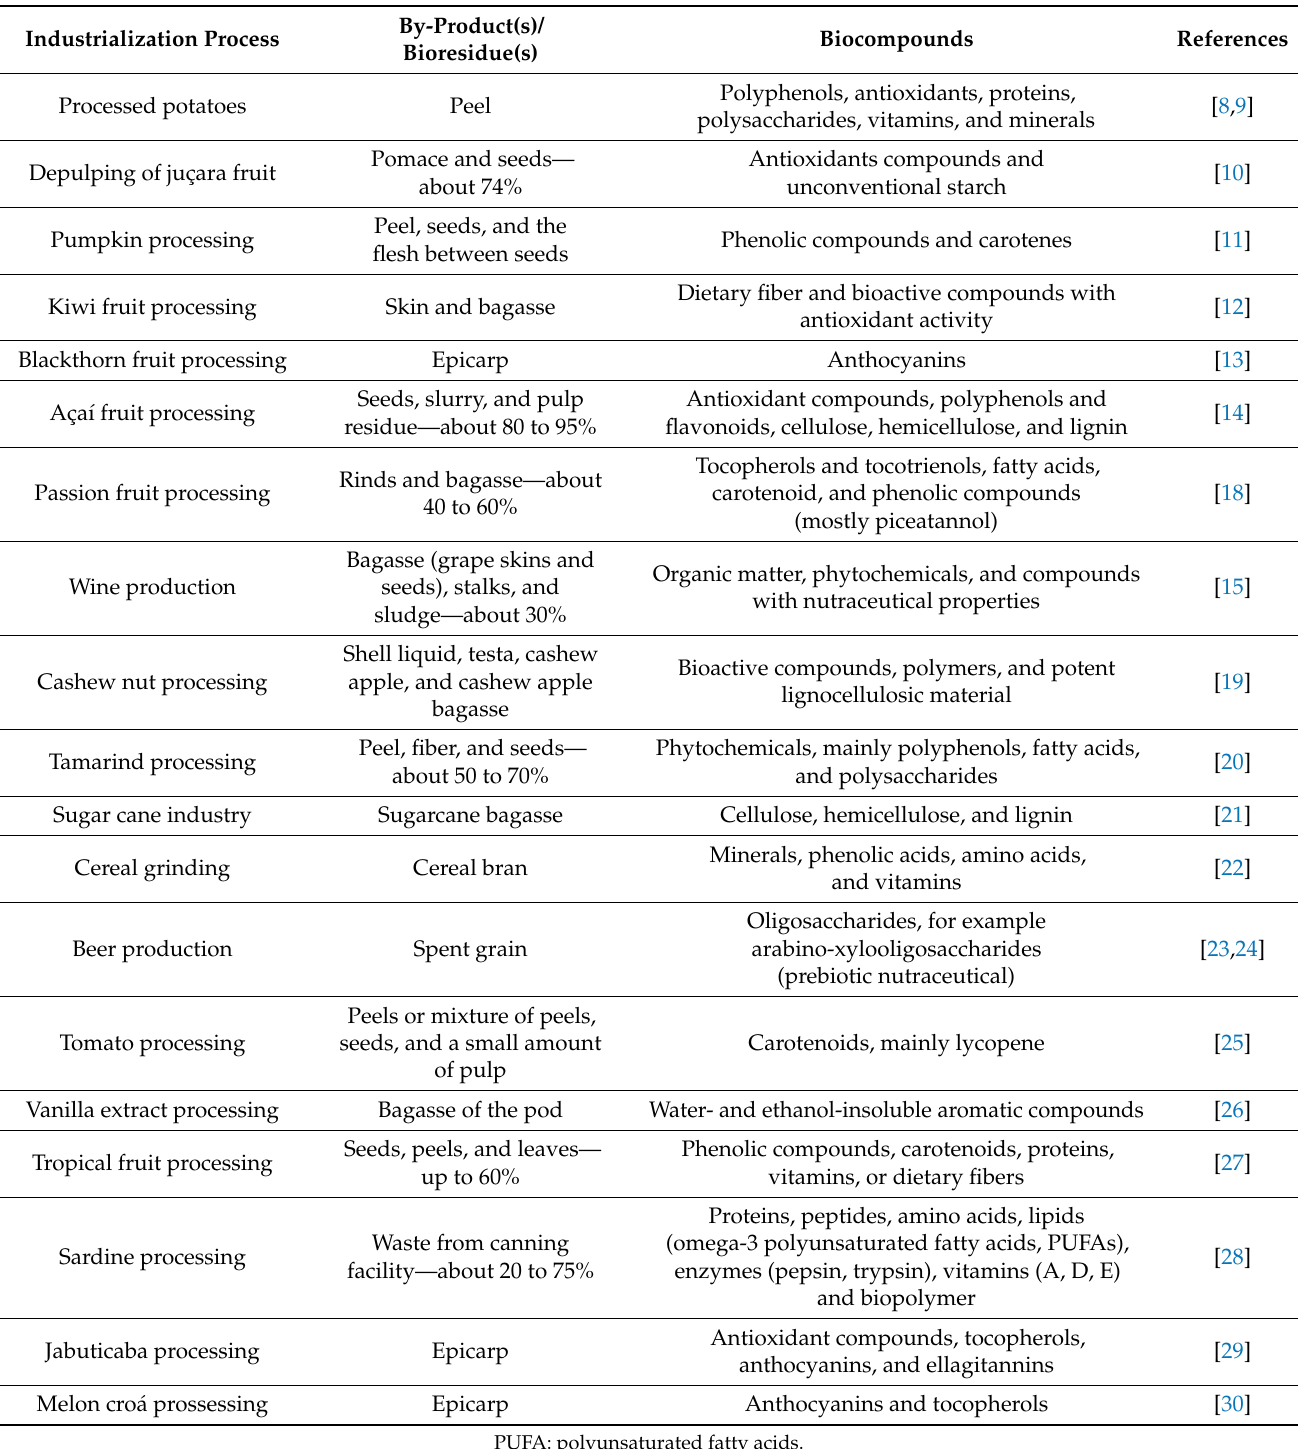
Table 1. Biocompounds found in bioresidues from food